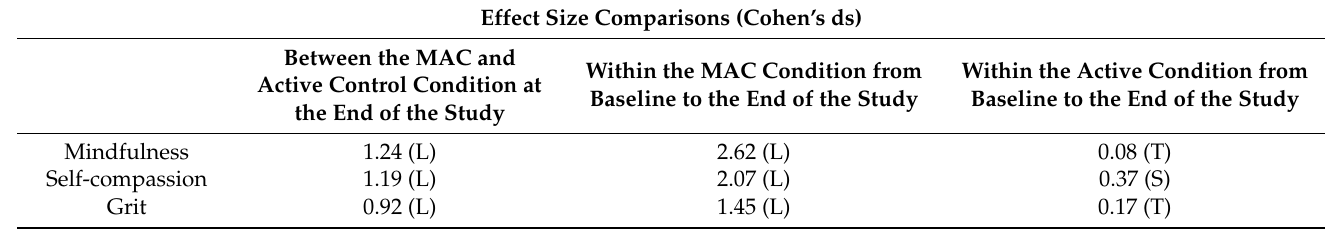
Table 5. Overview of effect sizes between group comparison at the end of the study and within group comparison from baseline to the end of the